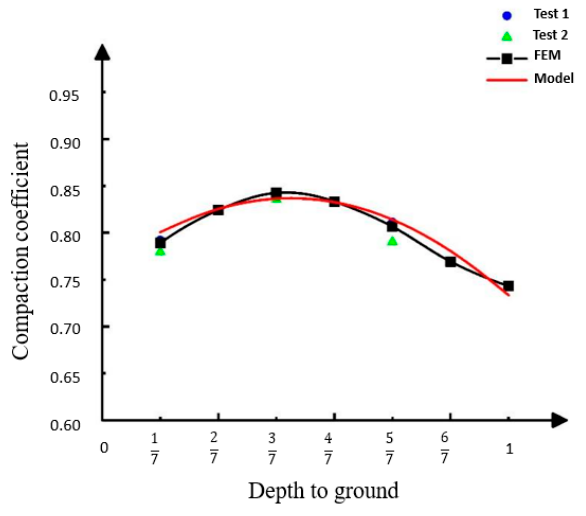
Figure 12. The relationship between the compaction coefficient at the edge midpoint and m. The parameter (cid:1865) was taken as the ratio of the depth from the focused point to ground to the pile length. The mechanical models of the change in the soil compaction coefficient at the centroid and the edge midpoint with the change in the parameter (cid:1865) were derived as ures 11 and 12).